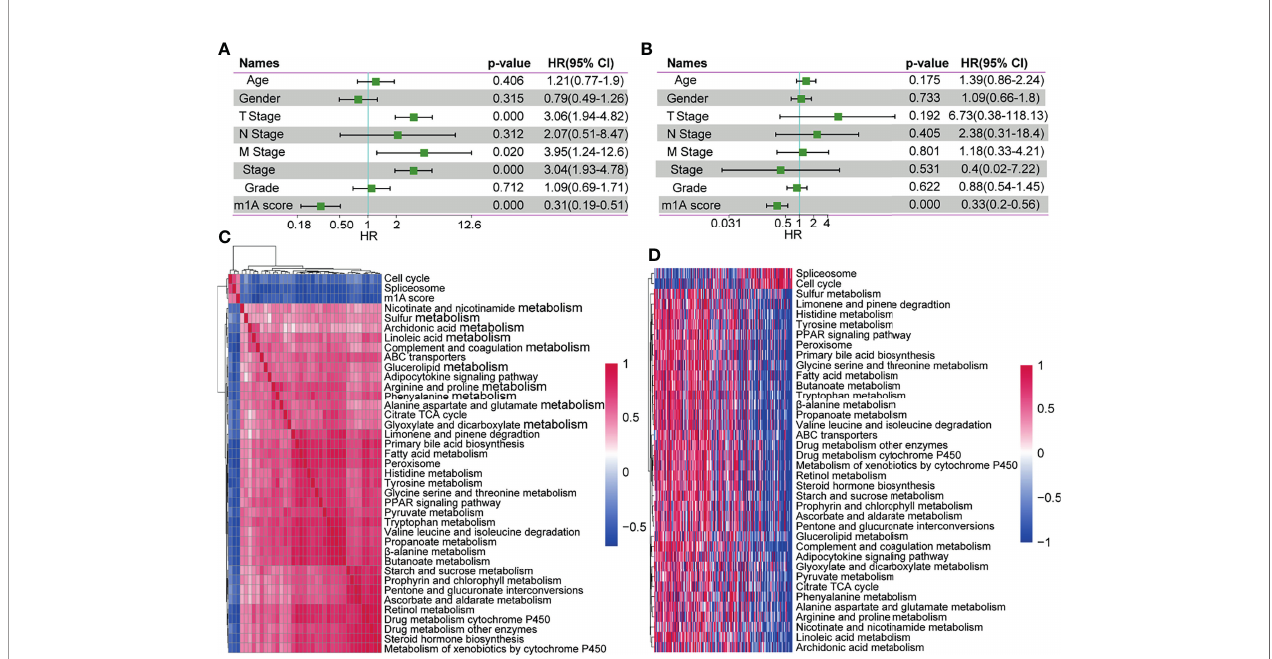
FIGURE 8 | The m1A-score model might serve as an independent prognostic biomarker in clinical application. (A, B) Univariate regression analysis and multivariate regression analysis of the m1A score in the whole TCGA-LIHC cohort. (C) Clustering of correlation coef fi cients between KEGG pathways with a risk score correlation greater than 0.4. (D) KEGG pathway analysis with a risk score correlation greater than 0.4. As the m1A score increases, the ssGSEA in each samplechanges